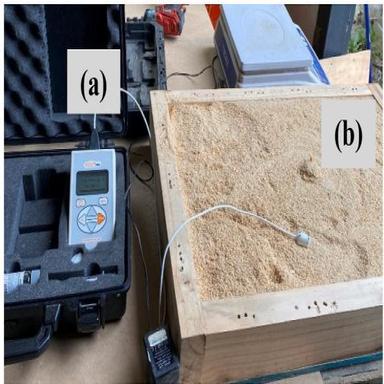
Measurement of thermal conductivity.